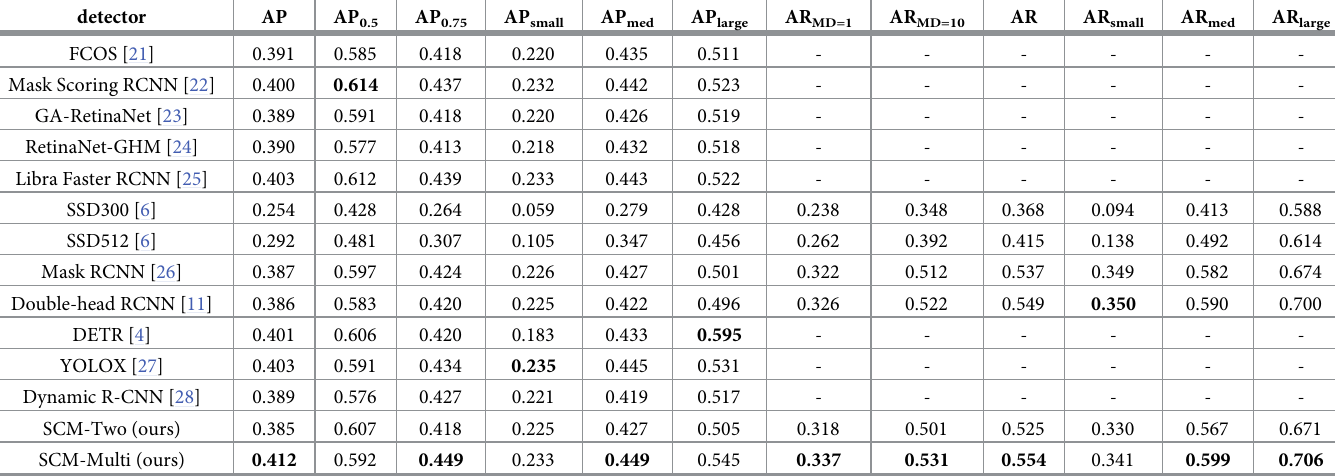
Table 3. Object detection quality comparison between structural-constraint-applied networks and other detectors on MSCOCO2017